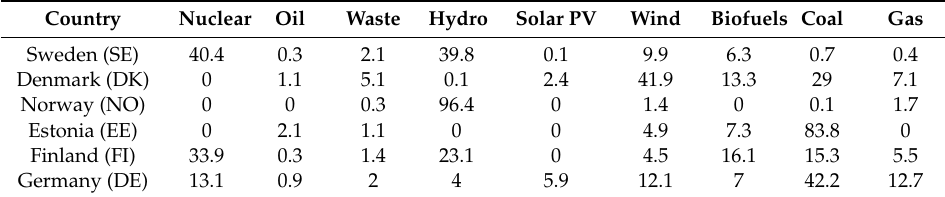
Table 5. Share of electricity generation by fuel on % 2018 [29].